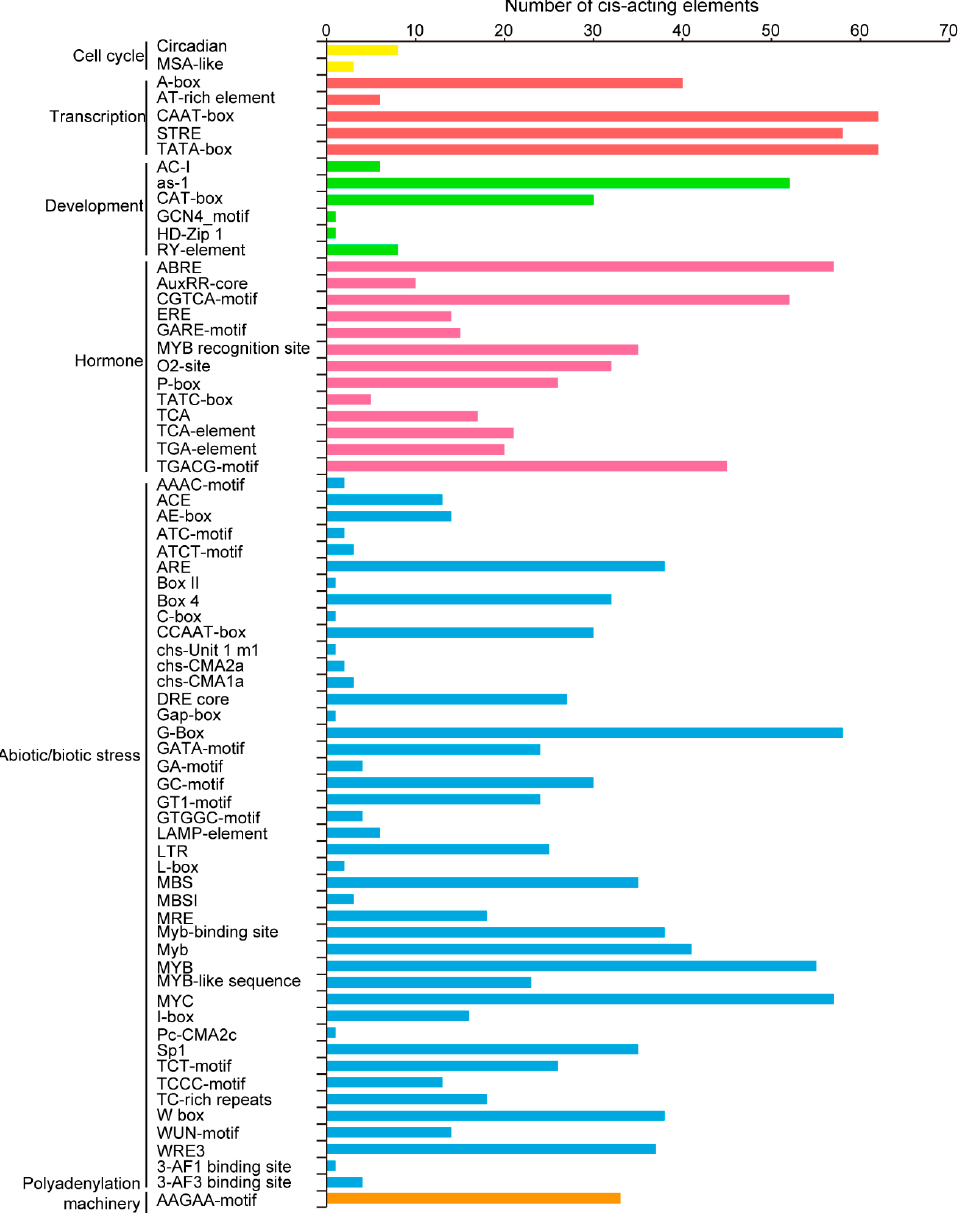
Figure4. Thenumberofcis-actingelementscontainedinthepromotersof TaPLATZ genes. Figure 4. The number of cis-acting elements contained in the promoters of TaPLATZ genes. The cis- acting element was identified with the online PlantCARE program using the 2k upstream from the